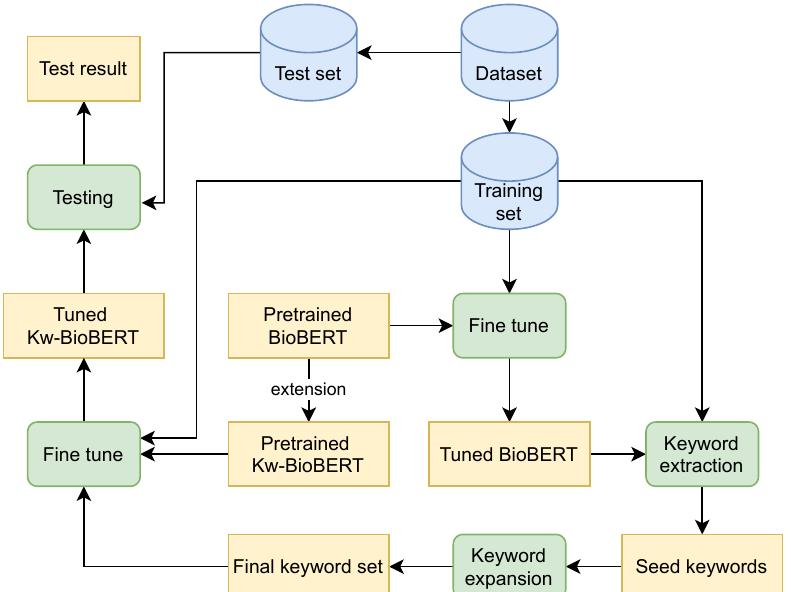
Figure 1. System framework. BioBERT is fine-tuned on the CDR training set. Then, the keyword extraction algorithm is applied to the tuned BioBERT model to generate a set of seed keywords, expanded to form the final keyword set. The BioBERT is changed to Kw-BioBERT and further tuned on the training set with the keyword attention mechanism enabled. Finally, the tuned Kw-BioBERT is evaluated on the CDR test